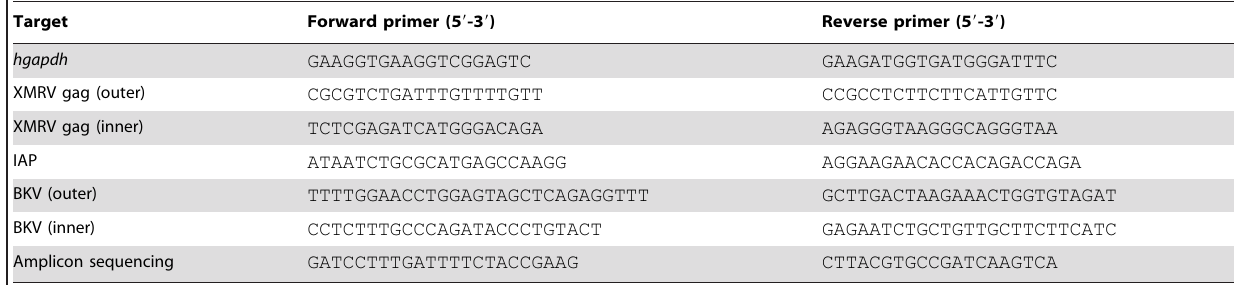
Table 2. Primers used in this